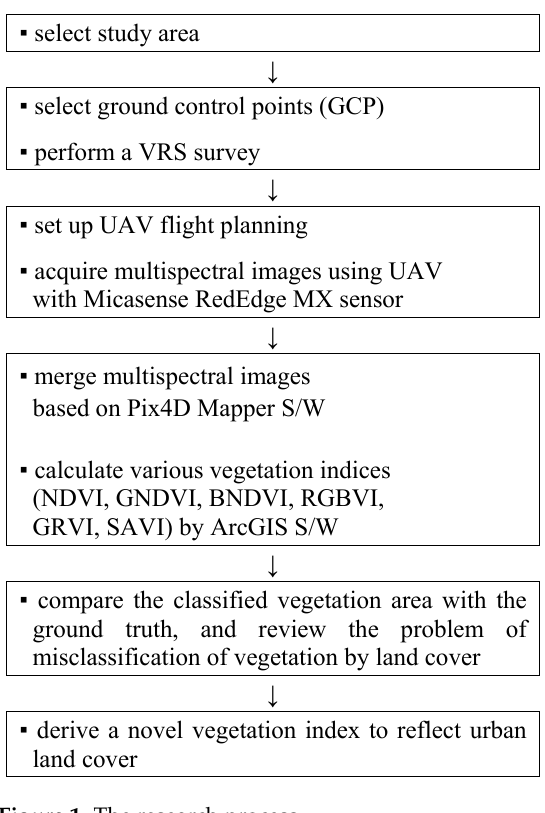
Figure 1. The research